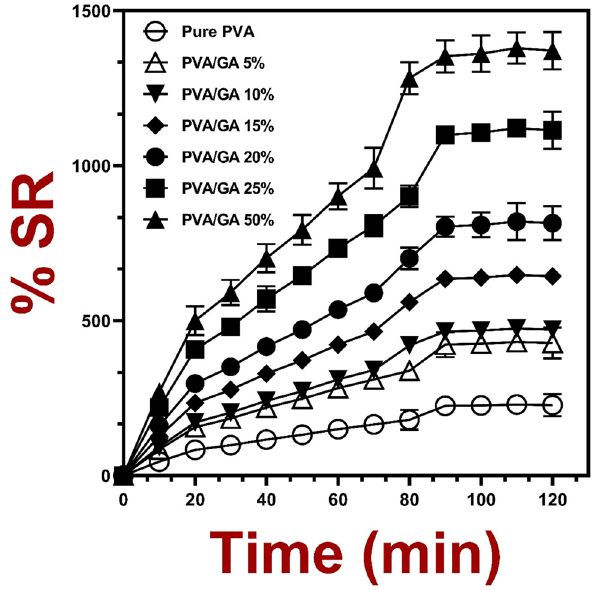
Figure 4: Percentage of the swelling ratio of the pure PVA and the PVA/GA x hydrogels. Concentrations ( x ) of GA are from 5% to